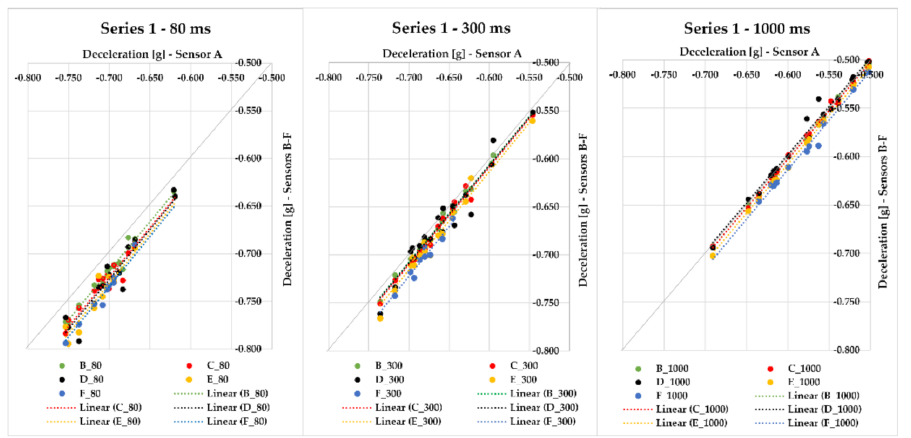
Figure 7. Series 1-Point dependency of individual MEMS sensors against sensor A.